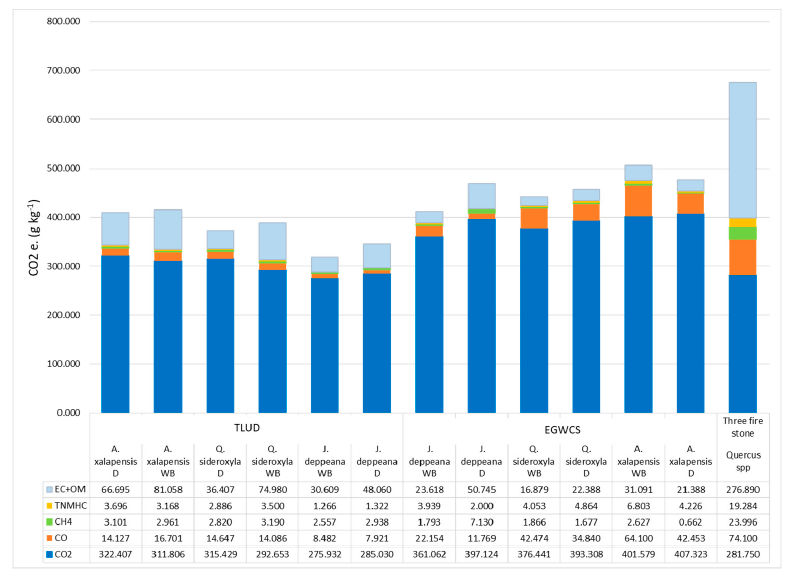
Figure 2. Carbon dioxide equivalent (CO 2 e) (g kg − 1 ) of dry pellets consumed (considering ele- mental carbon and organic matter). carbon and organic